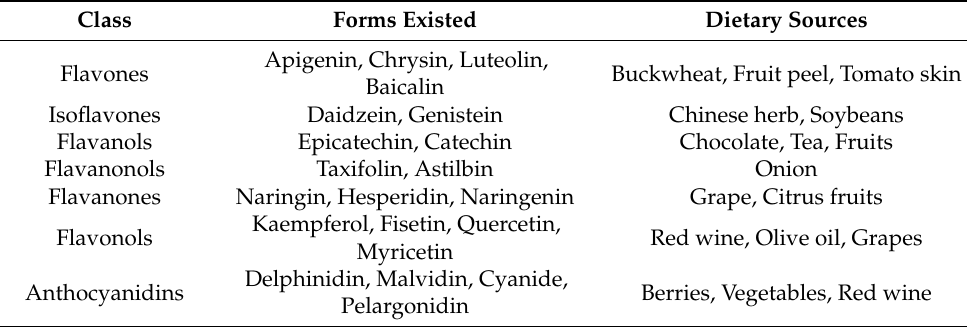
Table 1. Flavonoids: classification and food source classes.